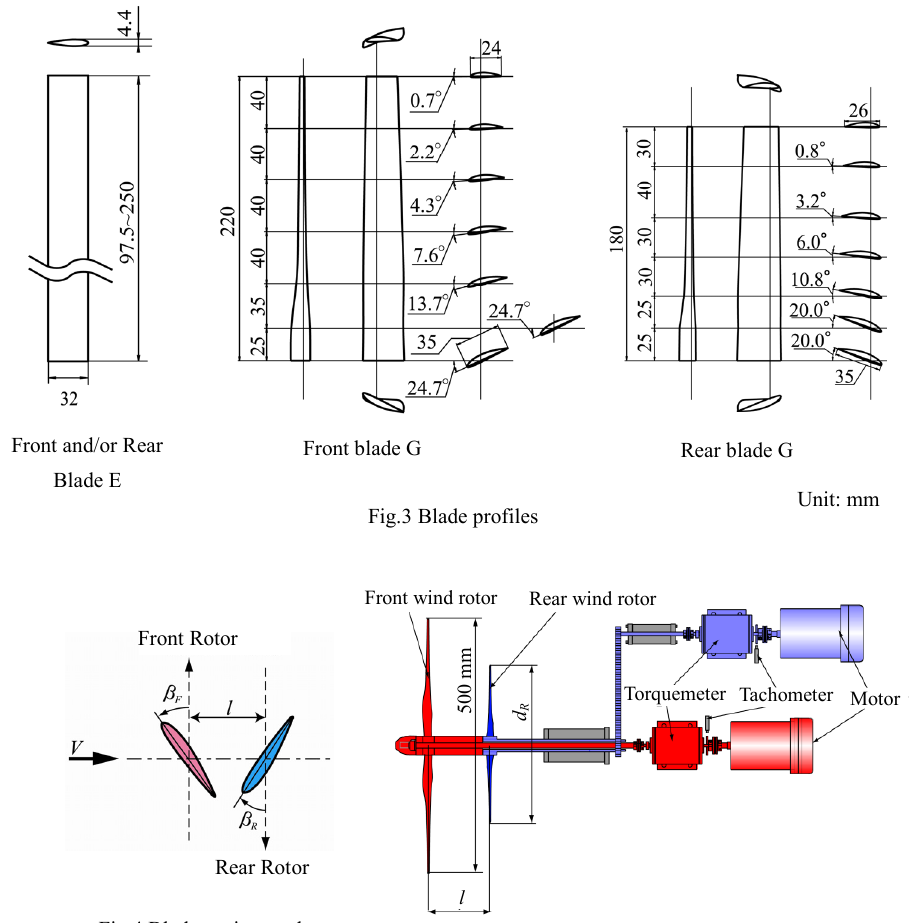
Fig. 5 Test stand for model tandem wind rotors Fig.4 Blade setting